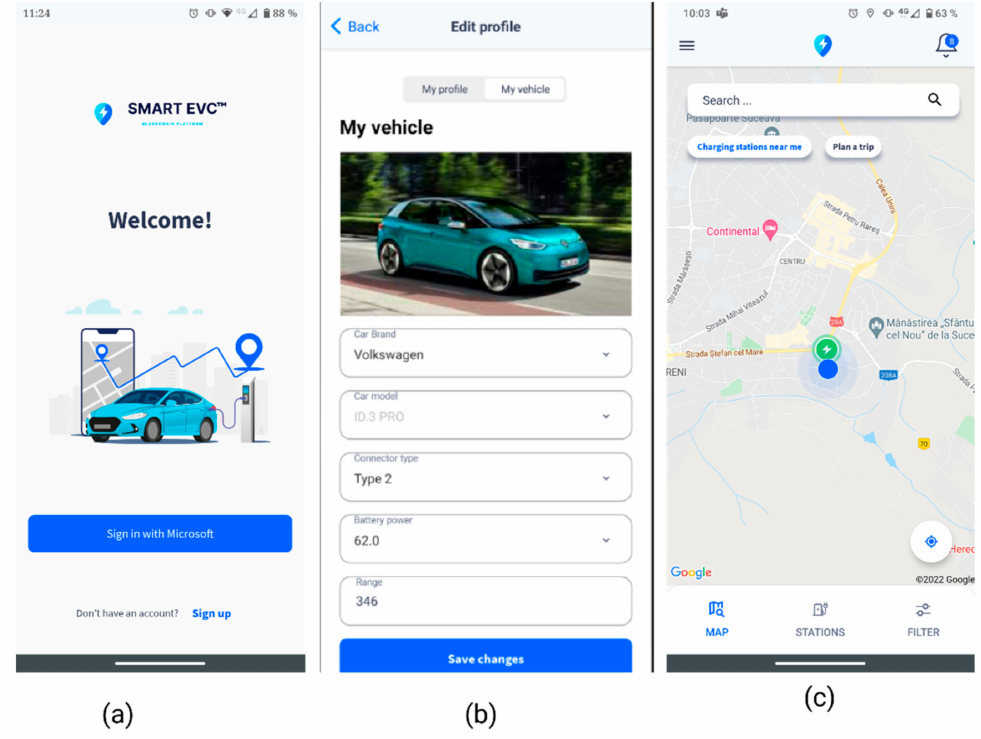
Figure 4. Smart EVC login, profile, and first page. ( a ) login page, ( b ) profile page, ( c ) map with current location and nearby charging